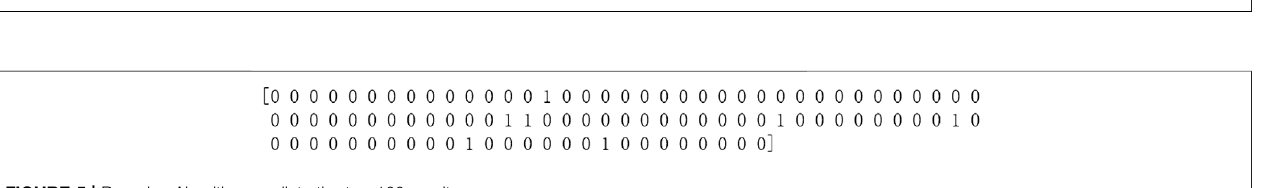
FIGURE 4 | Decision tree algorithm predicts the top 100 results.